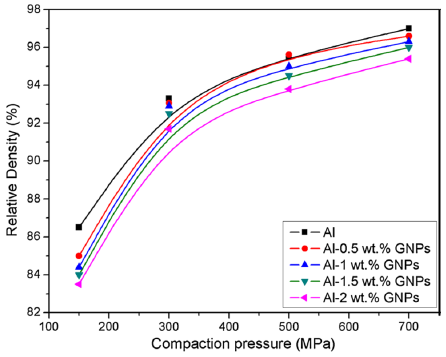
Figure 6. Compaction behavior of Al ‐ x wt. % GNP ( x = 0, 0.5, 1.0, 1.5, 2.0) nanocomposites, reproduced from [94], with permission from Springer Nature, 2018.